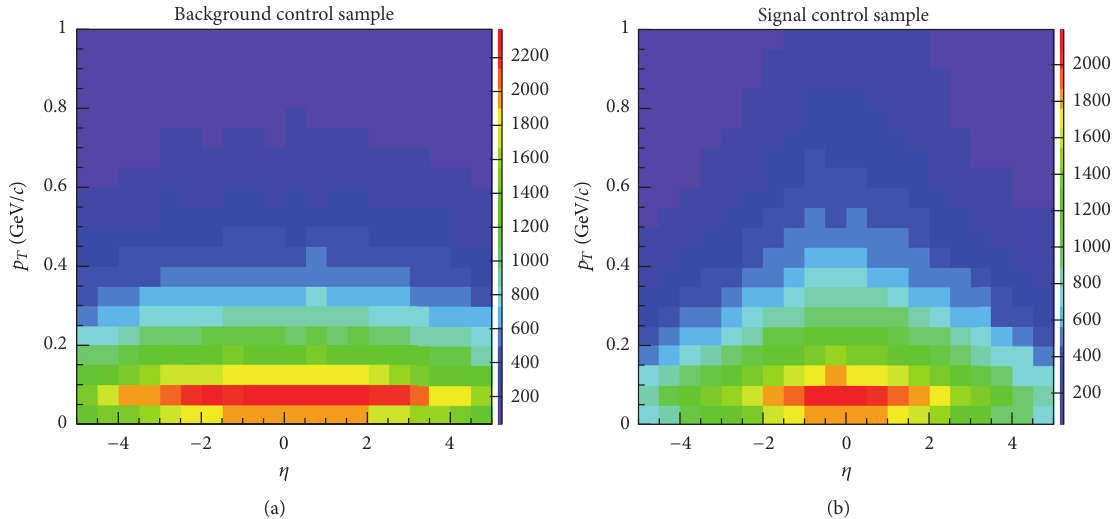
Figure 1: Particle-level (𝜂, 𝑝 𝑇 ) distributions from the control samples in the region of −5 < 𝜂 < 5 and 0 < 𝑝 𝑇 < 1 GeV /𝑐 , as described in the text. (a) Neutral soft QCD particles. (b) Neutral particles from the hard parton